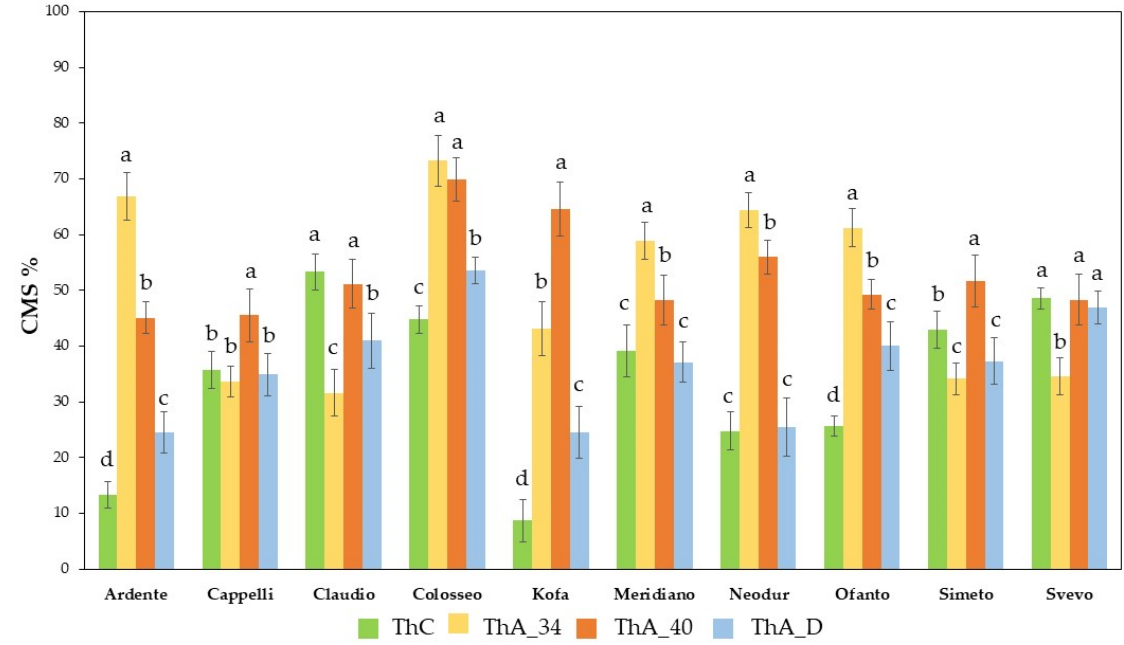
Figure 1. Thermotolerance of ten T. durum cvs evaluated using the CMS test. Individual bars represent the CMS values determined as: constitutive thermotolerance (ThC, green bar); acquired thermotolerance after a treatment at 34 °C for 24 h (ThA_34, orange bar); after heat shock at 40 °C for 2 h (ThA_40, red bar); after drought stress for 2 h (ThA_D, blue bar). The results are shown as the mean ± SD of ten independent measurements. For each cv, columns marked with different letters indicate a significant difference among treatments at p < 0.05 (ANOVA with post-hoc Bonferroni-Holm test).